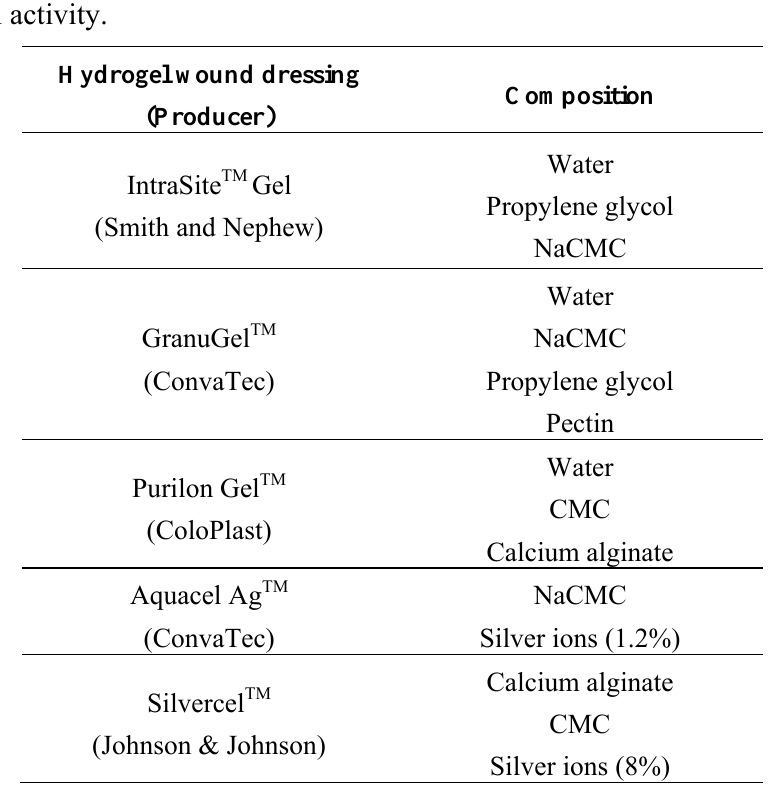
Table 1. Commercially available hydrogel wound dressings containing carboxymethylcellulose (CMC) or sodium CMC (NaCMC). Most dressings are available in two forms, either as sheets or as amorphous gels. Products containing silver ions show antimicrobial